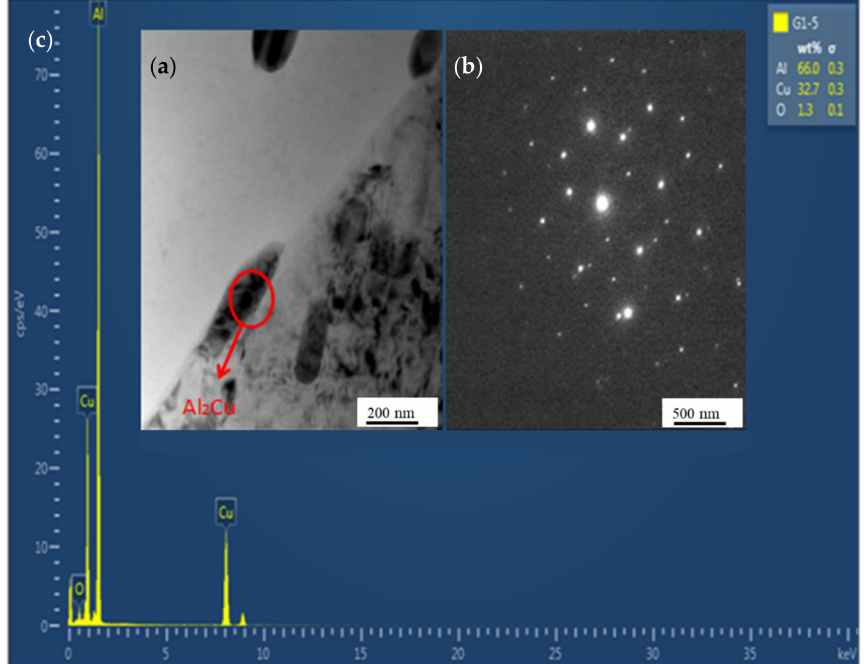
Figure 4. The morphology of Al 2 Cu particle precipitated along the grain boundary ( a ), and the corresponding diffraction pattern ( b ) and EDS result ( c